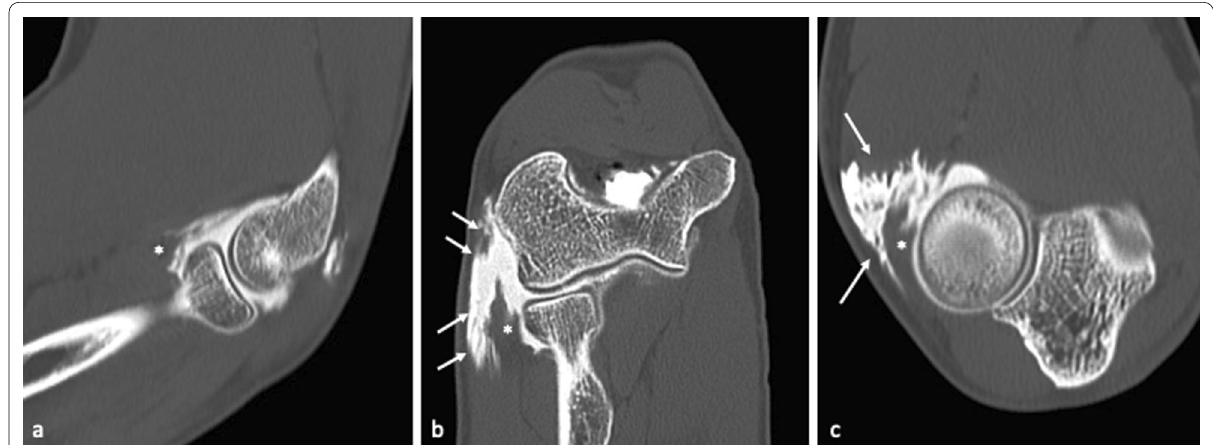
Fig. 9 Posterolateral rotatory instability (PLRI) sagittal, coronal and axial images ( a – c ). Full-thickness tear of the lateral collateral ligament (LCL) complex (white arrows) with extra-articular leakage of iodinated contrast medium within fibers of the common extensor tendon (asterisks)